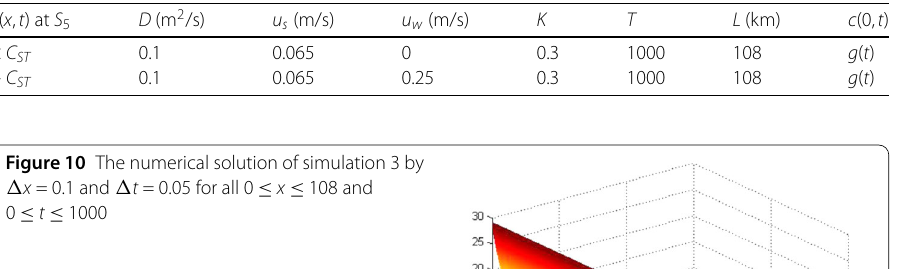
Table 8 Physical parameters of simulation 2 c ( x , t ) at S 5